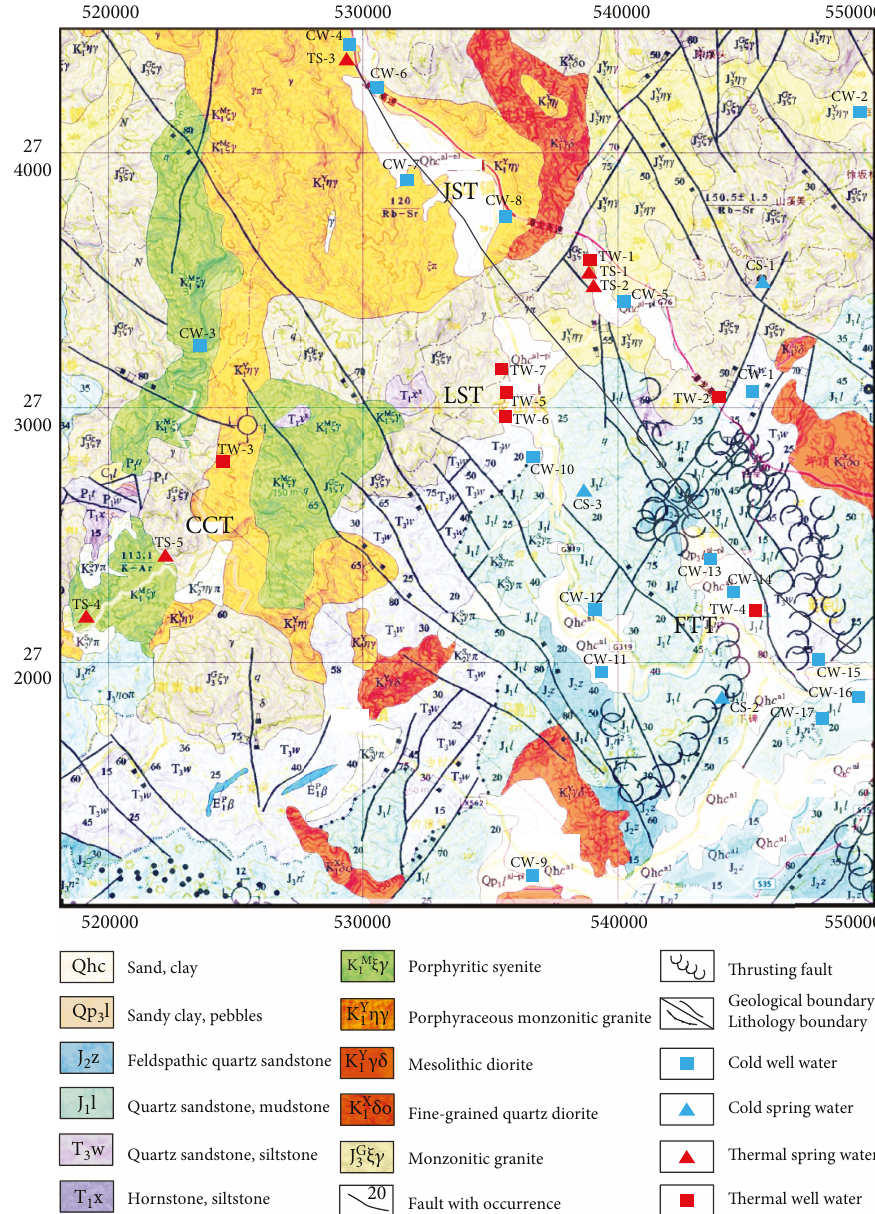
Figure 2: Geothermal and geological map for the NZB. JST: Jinshan Town; LST: Longshan Town; CCT: Chuanchang Town; FTT: Fengtian